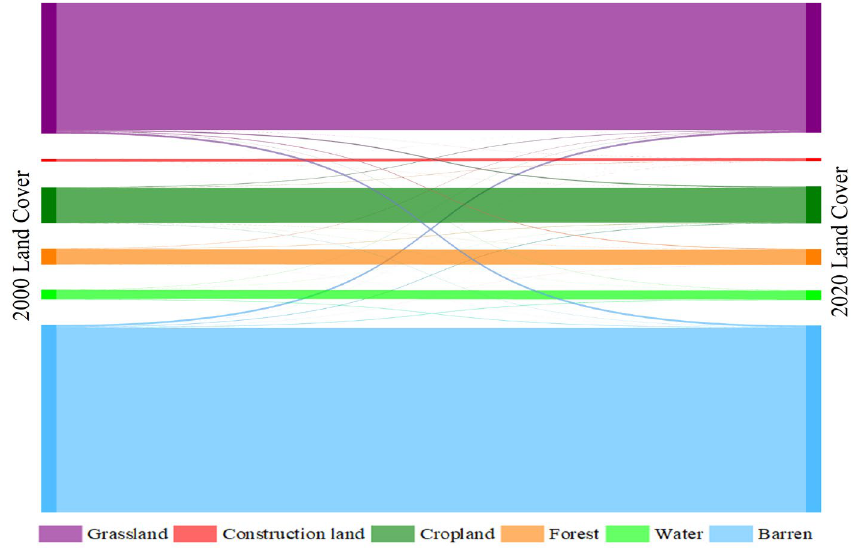
Figure 13. Land use change